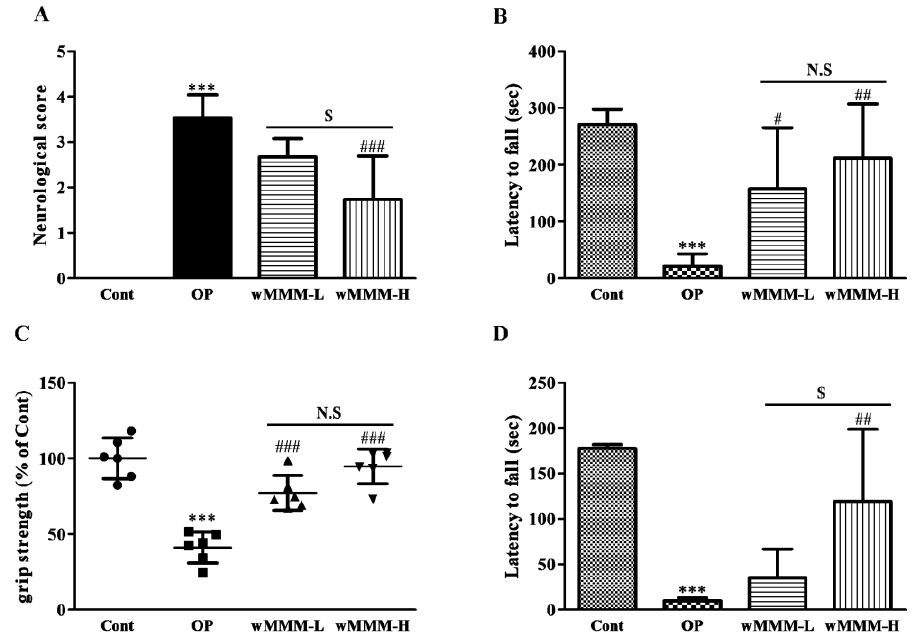
Figure 5. Attenuation of focal cerebral ischemia-induced sensorimotor deficits by water extracts of mixed mushroom mycelia (wMMM) administration. The graphs quantifying results from the neurological deficit scoring ( A ), the Rotarod test ( B ), the grip strength test ( C ), and the inverted screen test ( D ) were presented. In all graphs, data were presented as the mean ± standard deviation (*** p < 0.001 vs. Cont; # p < 0.05, ## p < 0.01, and ### p < 0.001 vs. OP; $ p < 0.05 vs. wMMM-L; N.S, not significant). In all graphs, significance was determined by one-way ANOVA followed by a Tukey post hoc test for pairwise comparisons (n per group = 6). Cont, control group; OP, the group with vehicle and middle cerebral artery occlusion and reperfusion (MCAO/R); wMMM-L, the group with low dose (30 mg/kg) of wMMM; and MCAO/R; wMMM-H, the group with high dose (90 mg/kg) of wMMM and